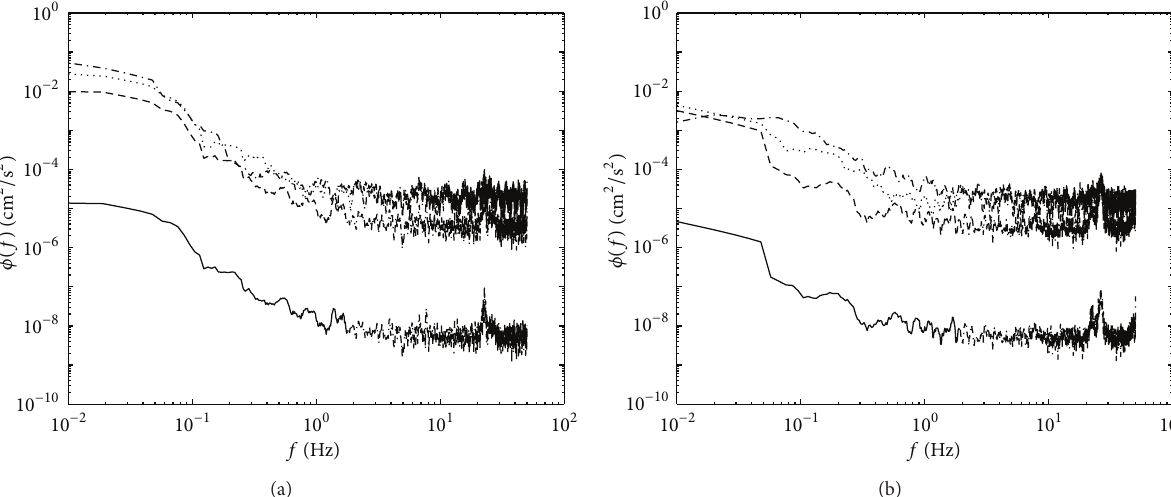
Figure 10: Plots showing the one dimensional frequency spectrum of (a) 𝜙 𝑢 (𝑓) and (b) 𝜙 𝑤 (𝑓) for a typical low 𝑅𝑒 𝑙 flow. The experiments shown correspond to 𝑅𝑒 𝑙 = 113 at 𝜉/ℓ 0 = 0.032 (solid), 0.317 (dashed), 0.634 (dotted), and 1.27